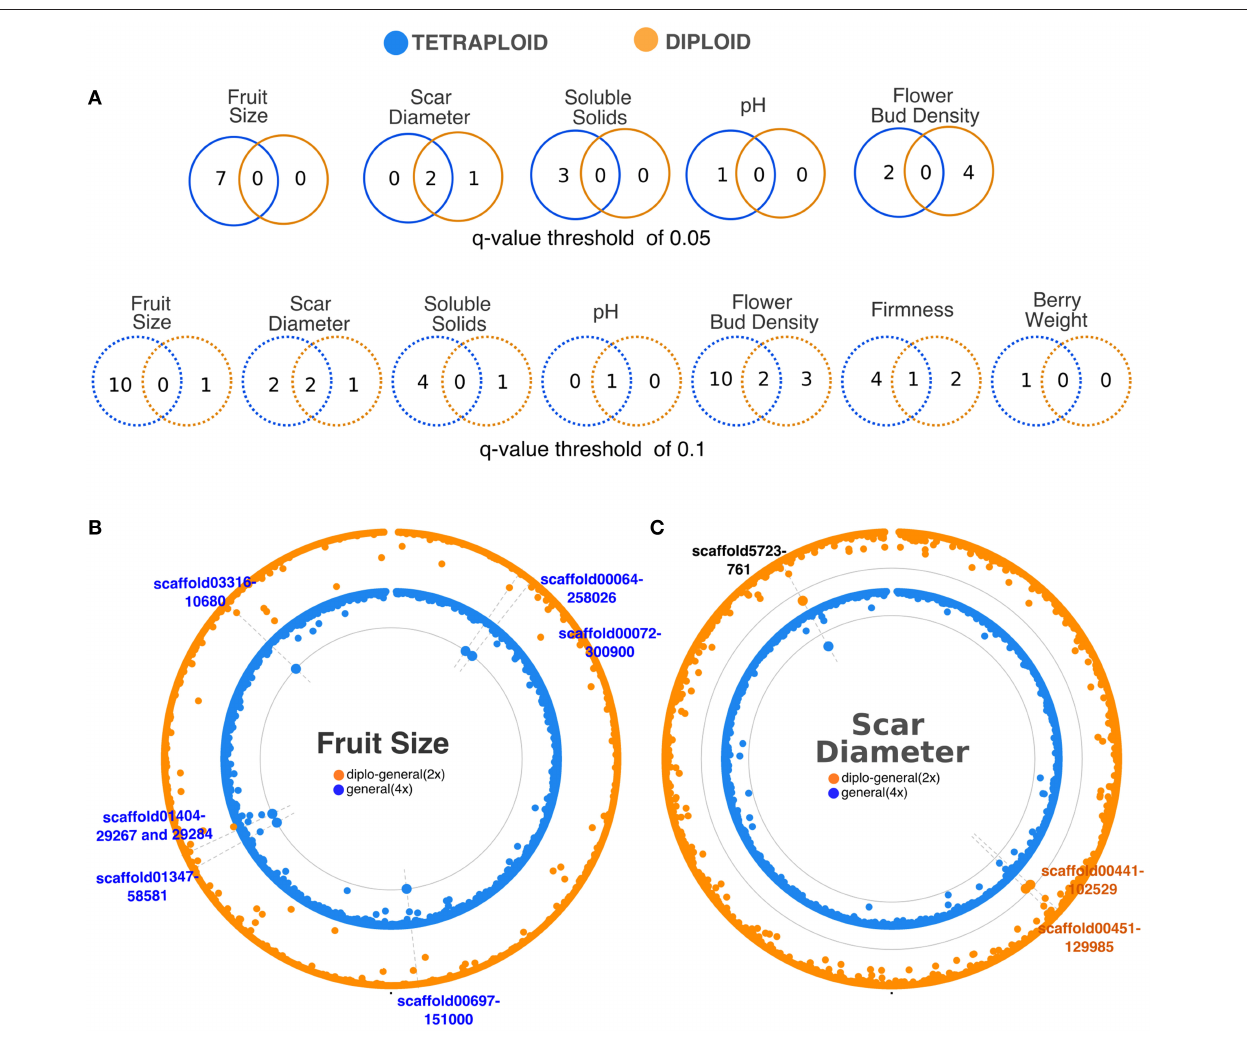
FIGURE 6 | SNP-trait associations detected by modeling tetraploid and diploid genotype callings. (A) Venn-diagrams comparing the number of distinct SNPs associated with fruit-related traits in the diploid and tetraploid scenarios under q -value thresholds of 0.05 (continuous lines) and 0.1 (dashed lines). (B) Circular Manhattan plot for fruit size. Outer and inner layers represent the diplo-general and general models fitted using diploid (2x) and tetraploid (4x) pipelines, respectively. (C) Circular Manhattan plot for scar diameter. Outer and inner layers represent the diplo-general and general models fitted using the diploid (2x) and tetraploid (4x) pipelines, respectively. SNPs were concatenated by their position in the genomic scaffolds and are displayed along the circular Manhattan plots according to their adjusted p -value. The significance threshold ( q -value = 0.05) is represented by the gray circle in each layer. Vertical dashed gray lines highlight the significant SNPs. The names of significant SNPs are listed outside of the plot. SNPs identified for diploid and tetraploid pipelines are in orange and blue, respectively; while the common SNP identified in both pipelines is in black.